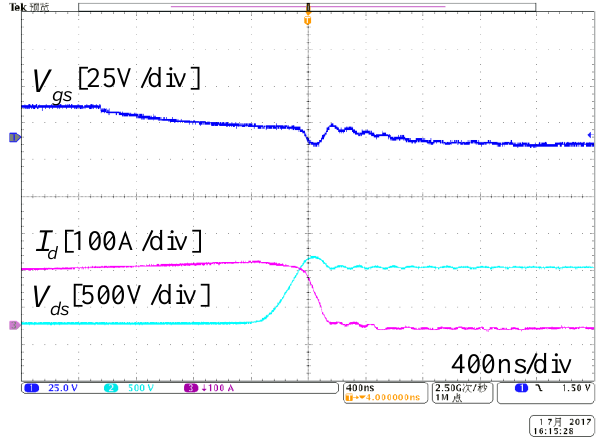
Figure 10. Turn-on characteristics with 𝑅 𝑔 = 15 Ω and 𝑇 𝑗 = 125 ℃ .